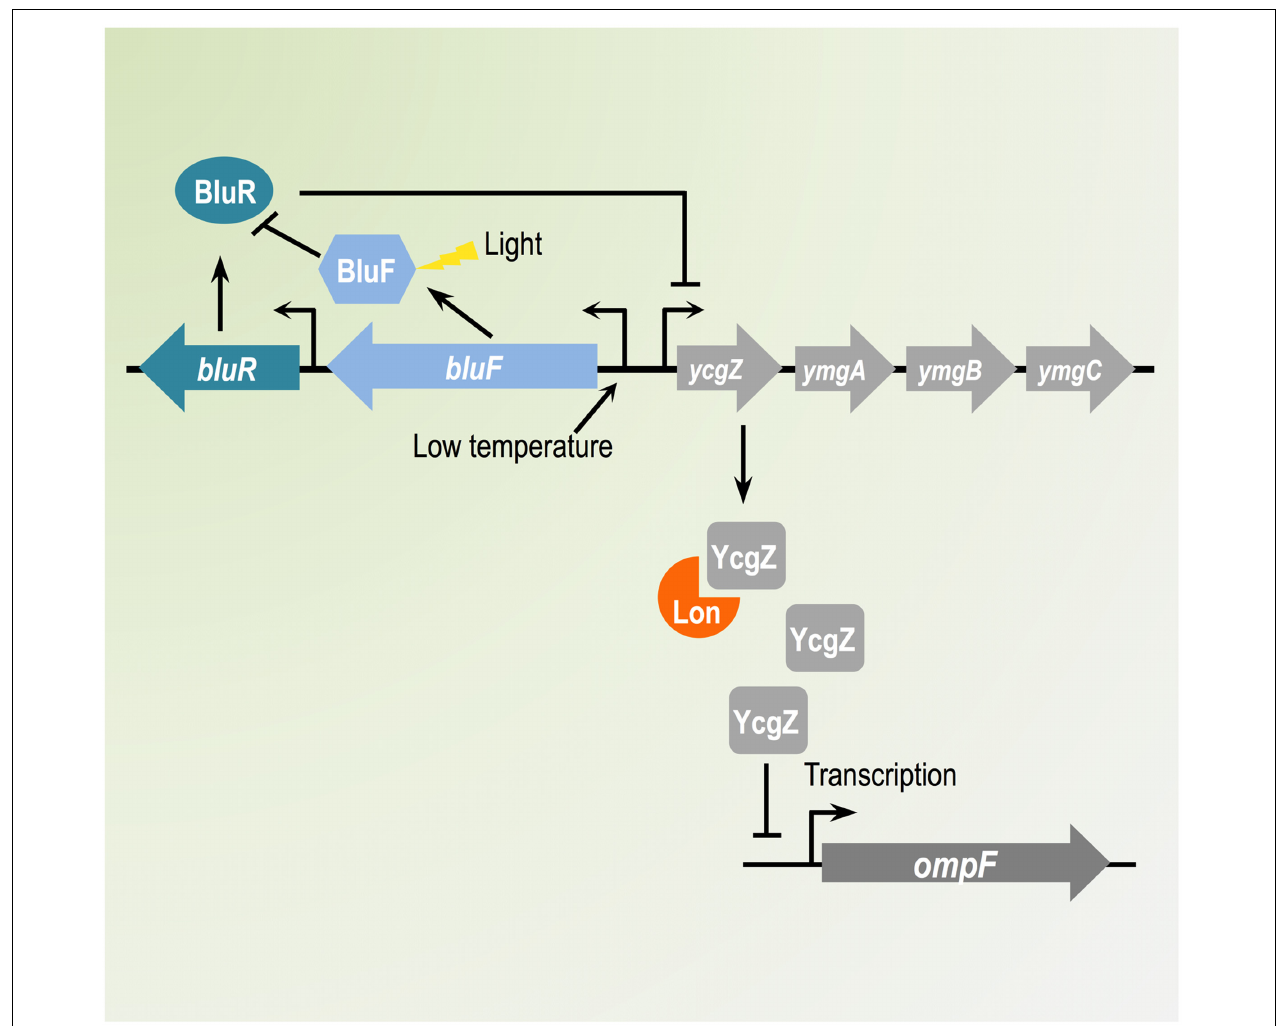
FIGURE 8 | Schematic representation of the regulatory cascade employed by BluR and Lon to control OmpF expression. In Escherichia coli , OmpF expression responds to environmental changes via complex regulatory networks. Our report described a novel pathway controlling OmpF synthesis at low temperature. The ycgZ-ymgABC operon, which transcription is controlled by the BluR-BluF system, encodes YcgZ, a protein highly unstable in the presence of the Lon protease. Increased amount of YcgZ leads to reduced transcription of ompF , consequently decreasing the amount of OmpF